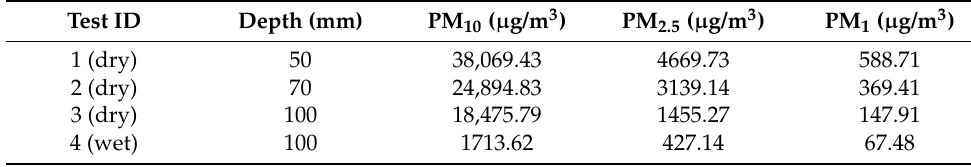
Table 5. Average PMC values according to cutting depth .